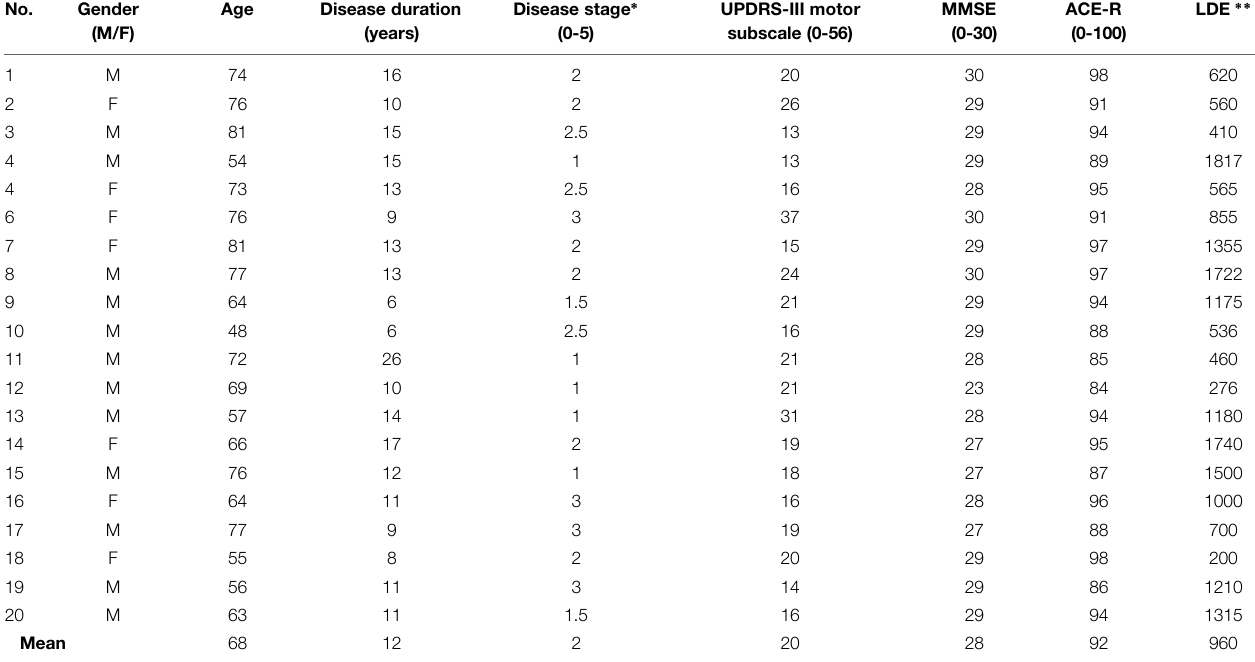
TABLE 1 | Demographic details of Parkinson’s disease (PD) patients participating in the study.